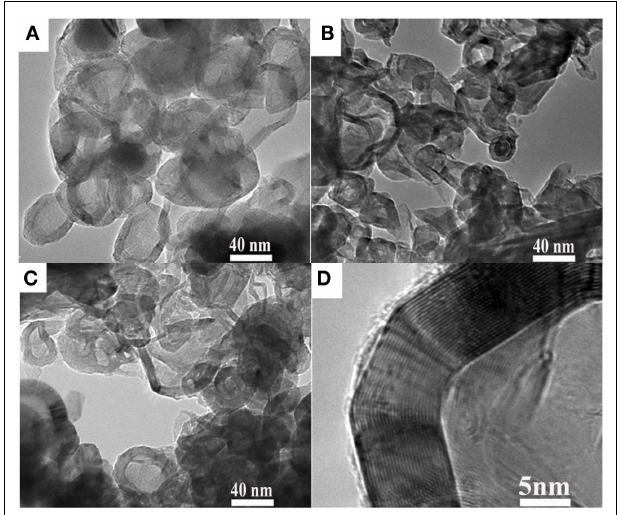
FIGURE 2 | TEM images of (A) pristine HCNS, (B) HCNS/S50 composite, and (C) HCNS/S80 composite . (D) HRTEM image of HCNS carbon wall showing highly graphitic character.